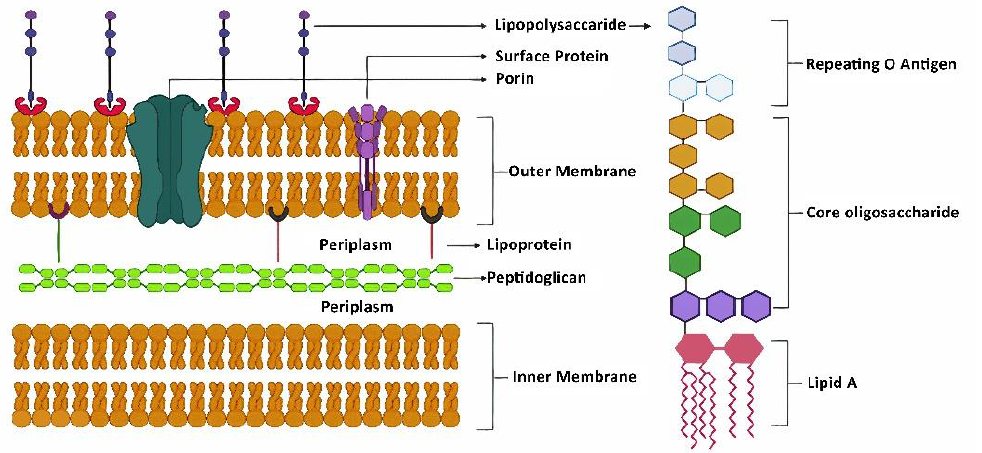
Figure 1. Structure of LPS embedded in the cell membrane of Gram-negative bacteria.